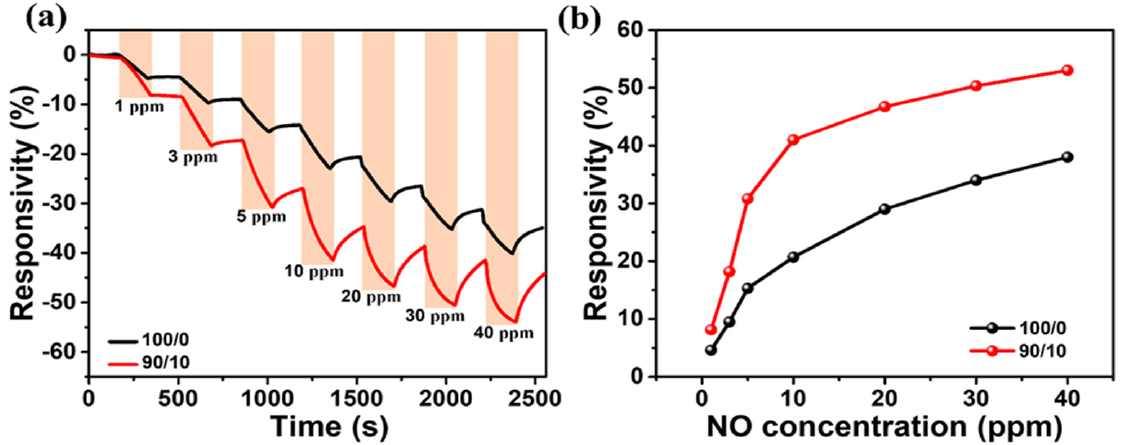
Figure 9. ( a ) Real − time responses of bare P3HT (100/0) and P3HT/g-C ₃ N ₄ (90/10) OFET sensors as a function of time with dynamic NO concentration. ( b ) Responsivity plots of the corresponding sensors as a function of NO concentration. Table 1. Comparison of the NO sensing performances of the prepared P3HT/g-C 3 N 4 sensors and other sensors reported in the literature.